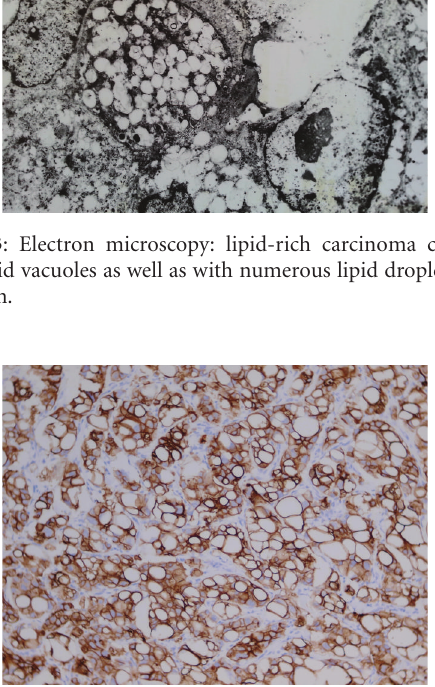
Figure 4: Lipid-rich carcinoma: immunohistochemical positivity of HER-2 (HercepTest